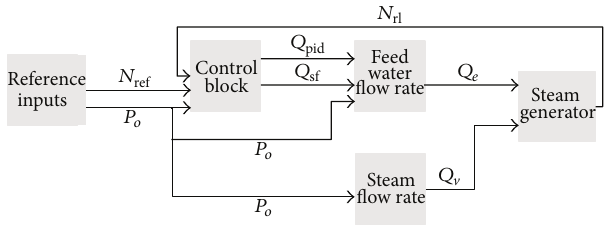
Figure 3: Block diagram representing the SIMULINK model of the SG.